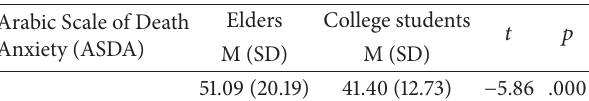
Table 2: Mean and standard deviation of the Arabic Death Anxiety Scale in Iranian elders ( 𝑁 = 146 ) and college students ( 𝑁 = 252 ). Arabic Scale of Death Anxiety